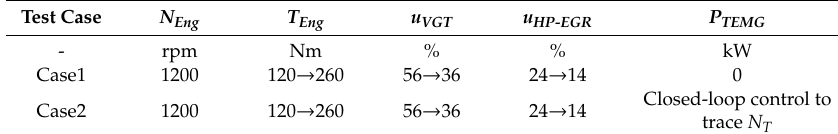
Table 6. Test case set-up for transient investigation of assist power.